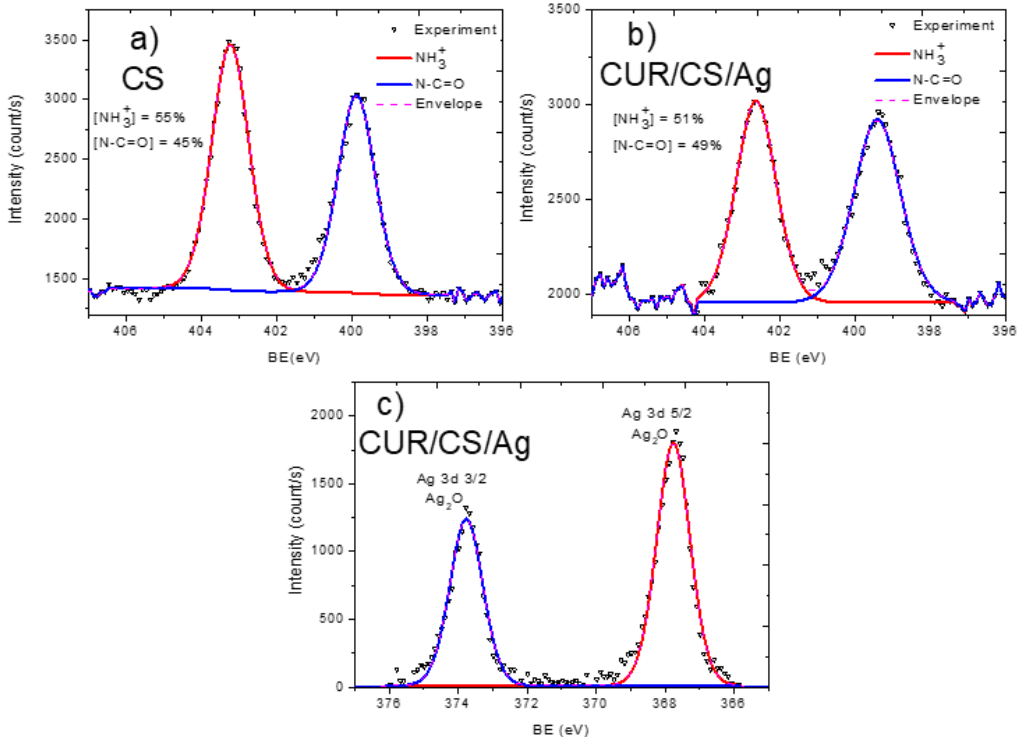
Figure 6. XPS curve fitting of N1s signal of CS ( a ) and CS-CUR-Ag ( b ) samples, and Ag 3D spectrum of CS-CUR-Ag ( c ).